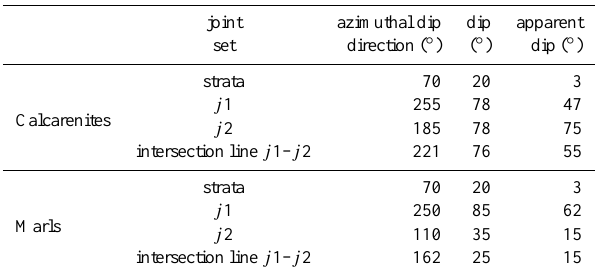
Table 1. Geomechanical properties derived from in situ measure- ments for the joint